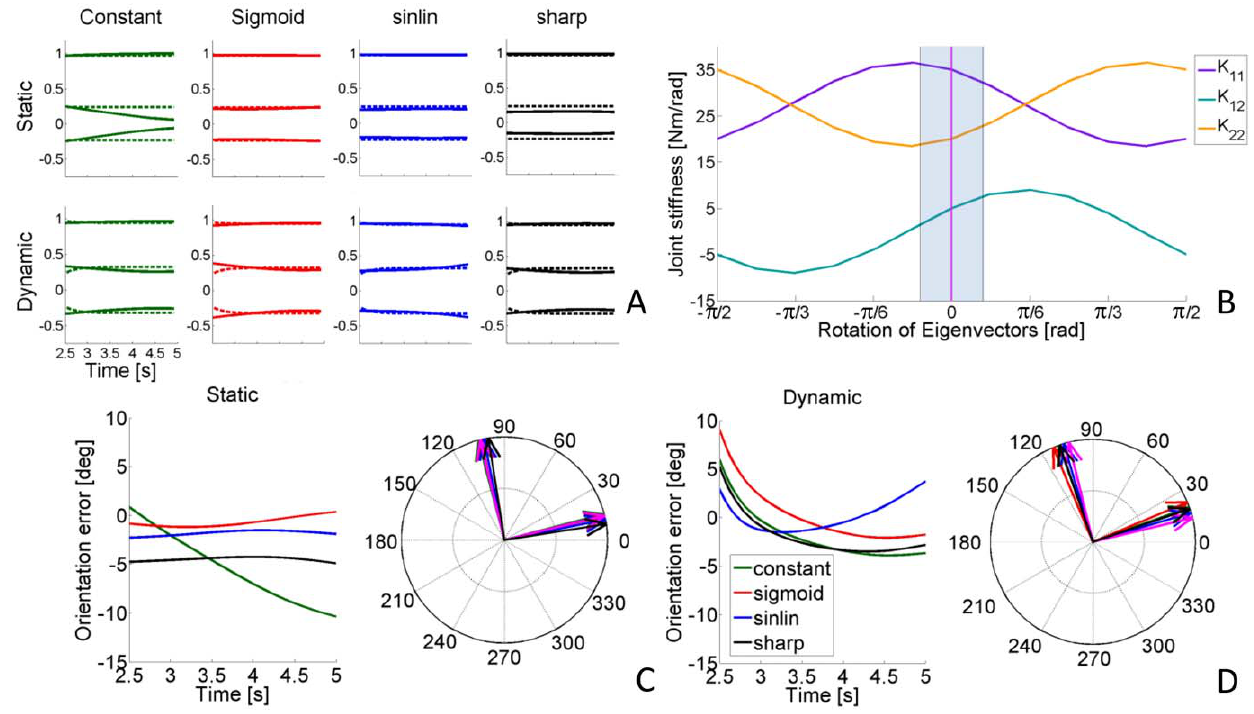
Figure 10. Representation of the eigenvectors and relative errors during simulations. A) FIRST ROW: Representation of the time-invariant coefficients of the eigenvector matrix P ( p 12 ~ p 21 ) for the static simulations. Dashed lines represent the coefficient of the imposed matrix P and solid lines represent the estimated P for the different stiffness time profiles: constant (green), sigmoidal (red), sinlin (blue), sharp (black). SECOND ROW: The coefficients of matrix P and their estimations for the dynamic case, where the variation of hand position makes the coefficients time-varying. B) Effect of misestimating the orientation of P on the stiffness coefficients. The estimations presented in this work are within the shaded blue area. C) RIGHT: Representation of the eigenvectors at the beginning of the estimation (time=2.5 s) for the postural case. Coefficients of the imposed matrix P are in magenta. LEFT: Error in the eigenvector orientation throughout the estimation time window. The reference eigenvectors are shown in magenta. D) Same as panel B for the dynamic condition.